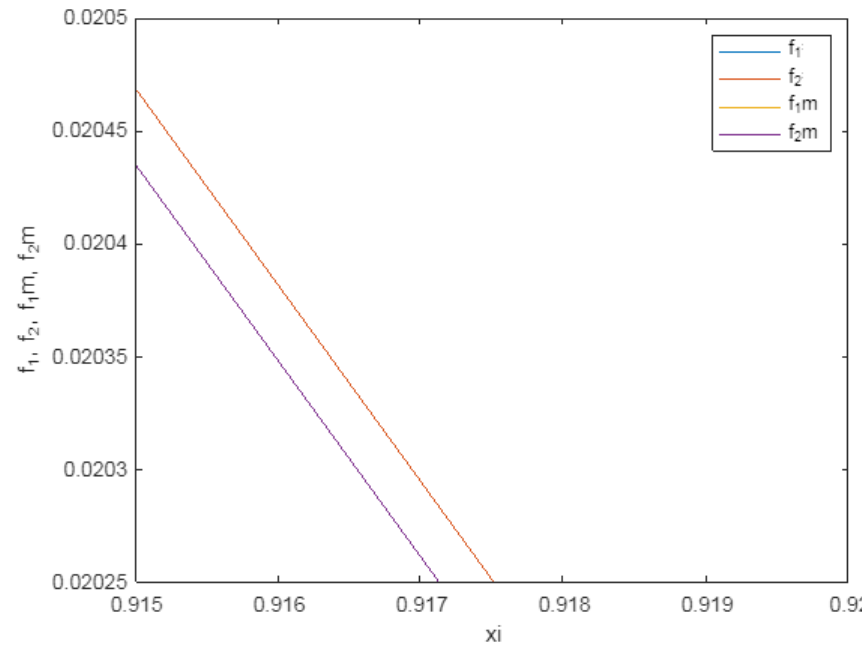
Figure 3. TW profiles for a + λ = 4 with n = 0.9, m = 0.1. For the sake of simplicity, r = 2. Note the lower solution ϕ 2 m as the solution for the problem (20). The numerical exercise was performed for an integration interval ( 0,100 ) ; nonetheless, the interval was cut for representation purposes. Note that f 1 and f 2 represent ϕ 1 and ϕ 2 solutions to (19) while f 1 m and f 2 m are solutions to (20).